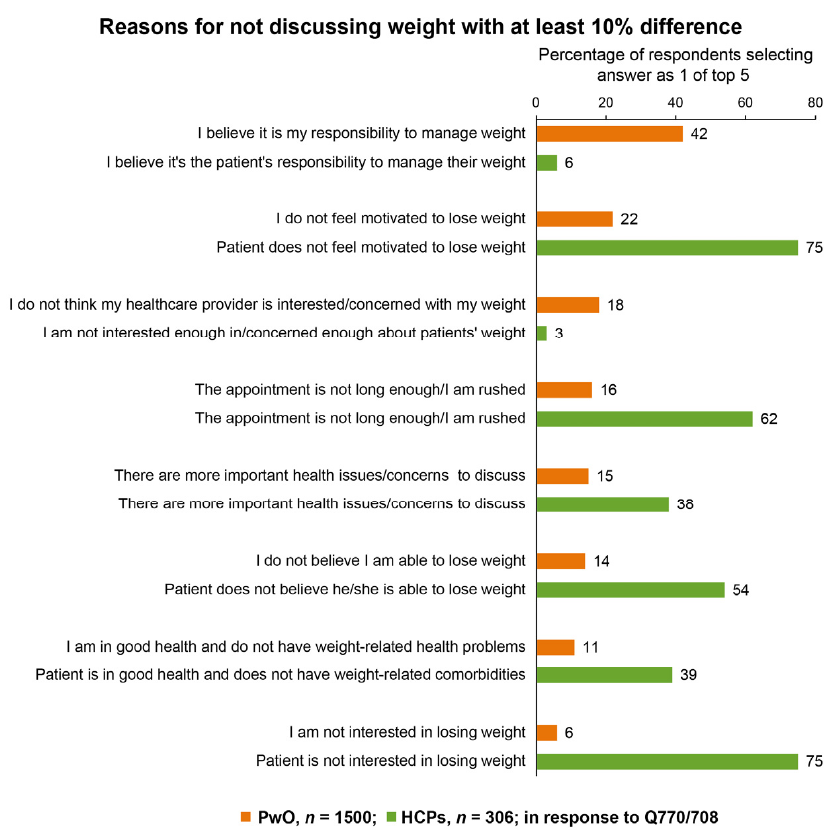
Figure 4. Reasons for not discussing weight with an HCP (PwO, orange) or patient (HCPs, green) with at least 10% di ff erence. Respondents selected their top 5 reasons from the list of options. Reasons for not discussing weight with an HCP or patient with at least 10% di ff erence between PwO and HCPs are presented. See Supplementary Figure S2 for all reasons. HCP, healthcare professional; PwO, people with